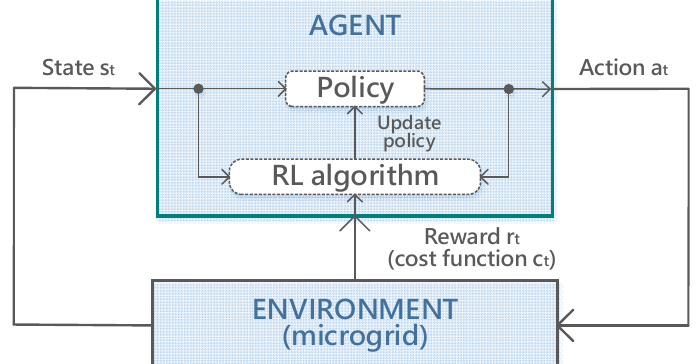
Figure 1. The main reinforcement learning (RL)-based approach for the energy microgrids’ optimal